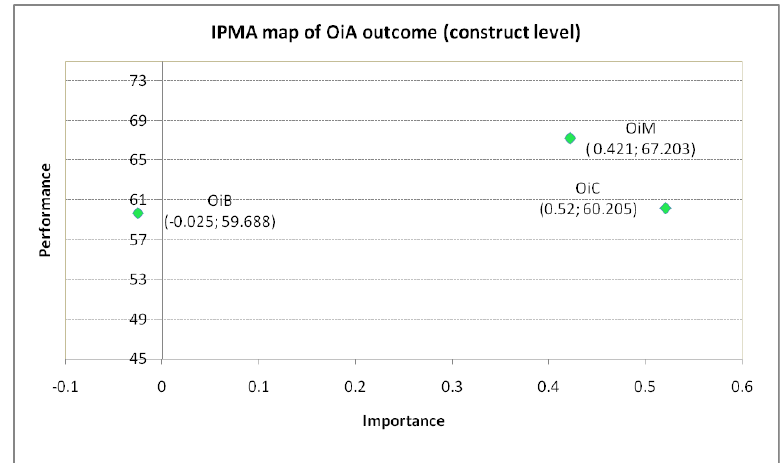
Figure 3. The IPMA map of the target OiA outcome (construct level).